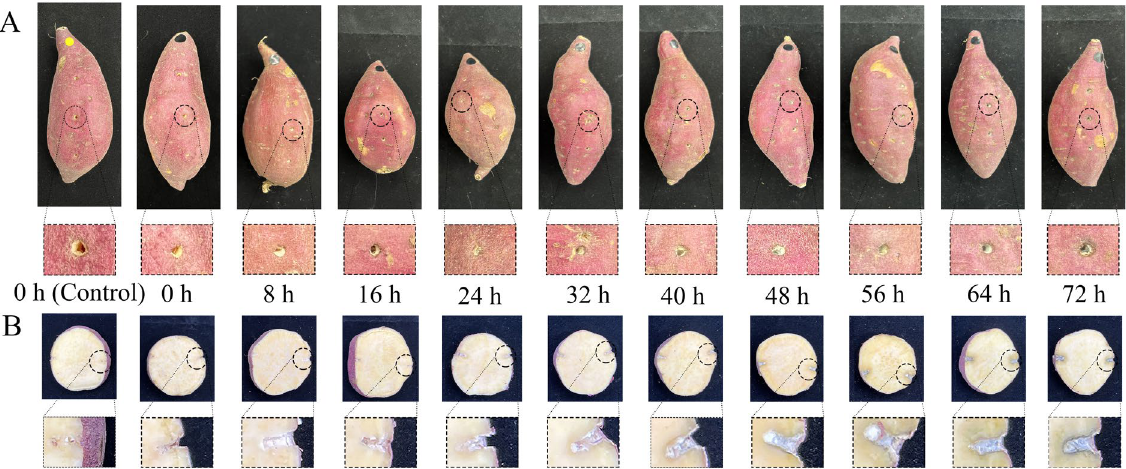
Figure 3. Pathological disease process of sweetpotatoes inoculated with C. fimbriata from 0 to 72 h. ( A ) Surface disease symptoms. ( B ) Internal disease symptoms.